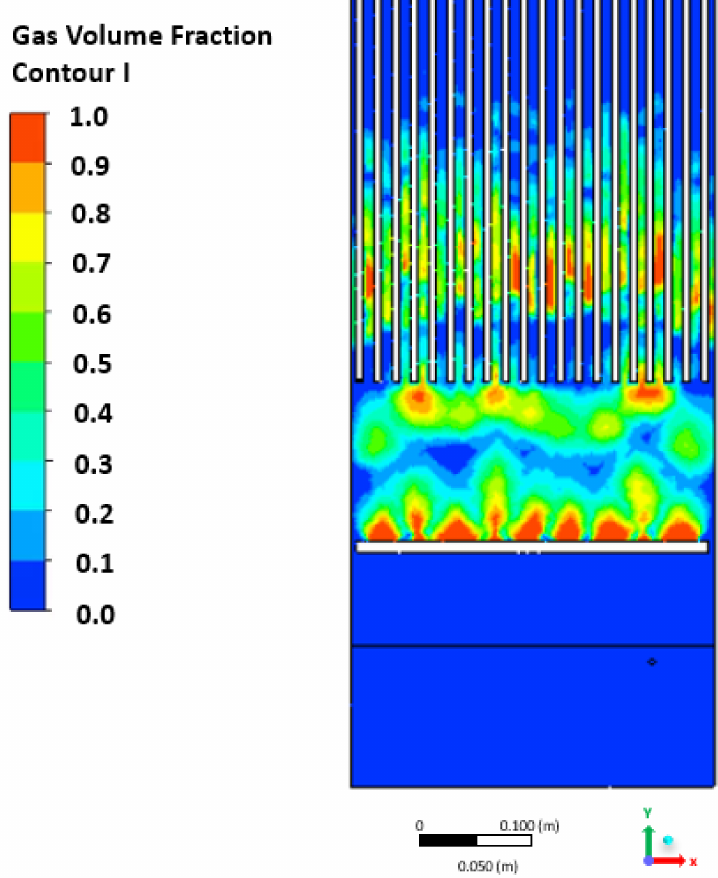
Figure 2. CFD analysis result for air flow with the intermittent aerator cassette.